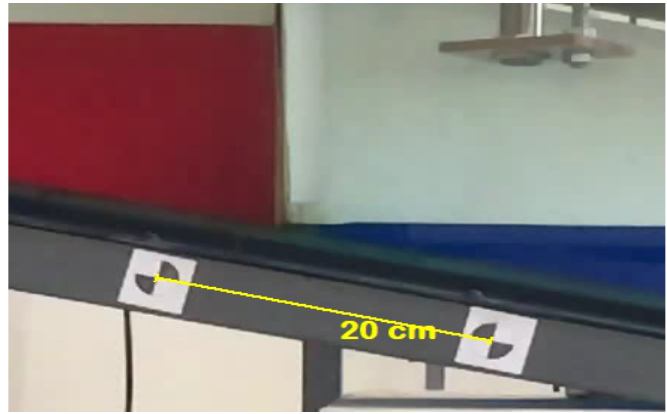
Figure 4. Reference markers for the image processing.